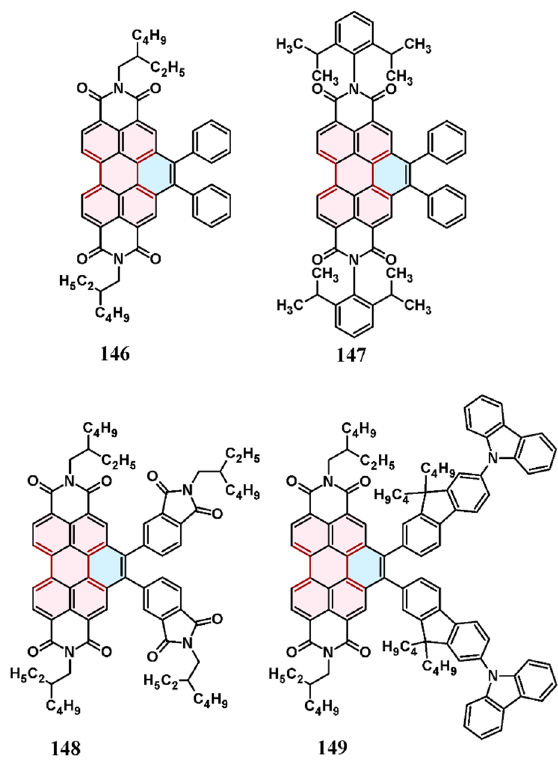
Figure 3. Synthesis of 2,3-diaryl- N , N ’-bis(2,6-diisopropylphenyl or 2- ethylhexyl)benzo[ ghi ]perylenediimides via the cycloaddition of 1,2-diarylacetylenes to N , N ’-bis(2,6- diisopropylphenyl)- or (2-ethylhexyl) benzo[ ghi ]perylene diimides bay regions: list of obtained products [152]. Y = 27% ( 146 ); 46% ( 147 ); 15% ( 148 ); and 10% ( 149